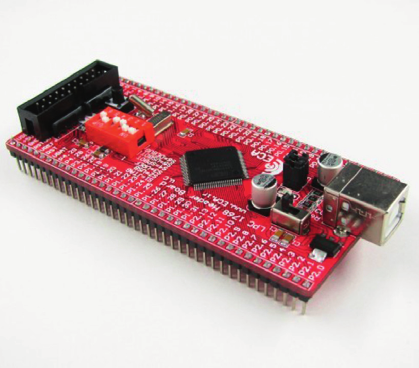
Figure 4: Arm Cortex-M board.